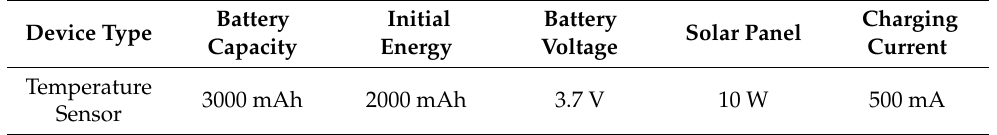
Table 2. IoT device specification used in the